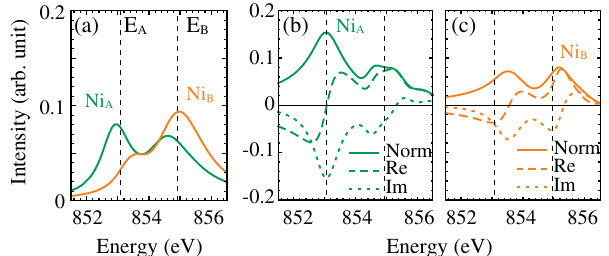
FIG. 5. Site-resolved (a) XAS and (b,c) XMCD spectra described through the complex circular dichroic form factor σ ð 1 Þ [50] calculated using the double-cluster model. The spectra for the expanded and compressed Ni sites are plotted in green and orange, respectively. The two vertical dashed lines mark the energies E (left) and E (right) within each A B